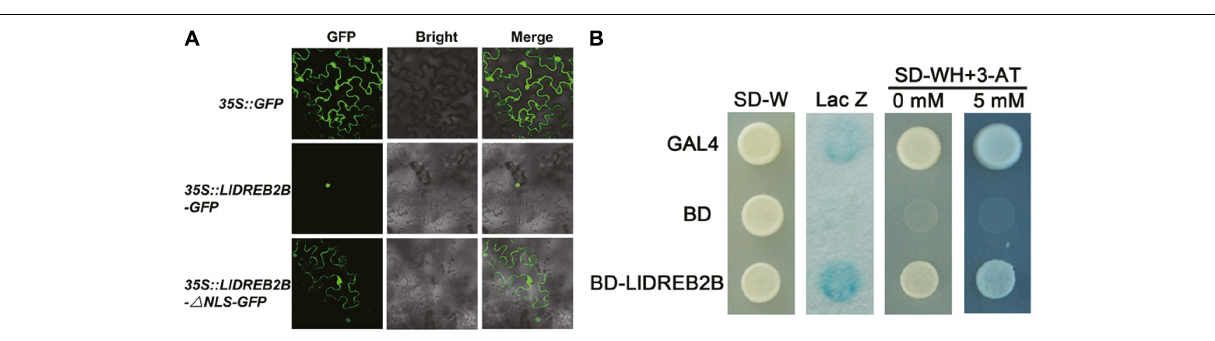
FIGURE 4 | Subcellular localization and transactivation assay of LlDREB2B protein. (A) Transient expression profiles of LlDREB2B in tobacco leaves. Confocal microscopy of tobacco leaf cells transfected with LIDREB2B or LIDREB2B-ANLS fused to the N-terminal GFP reporter gene controlled by the 35S promoter. Empty GFP vector served as a negative control. (B) Transactivation activity of LlDREB2B in yeast cells. GAL4 and BD were used as positive and negative controls, respectively. SD-Trp (SD-W) medium was used to detect transformation, SD-Trp/-His (SD-WH) medium with or without 3-AT (3-amino-1,2,4-triazole, a